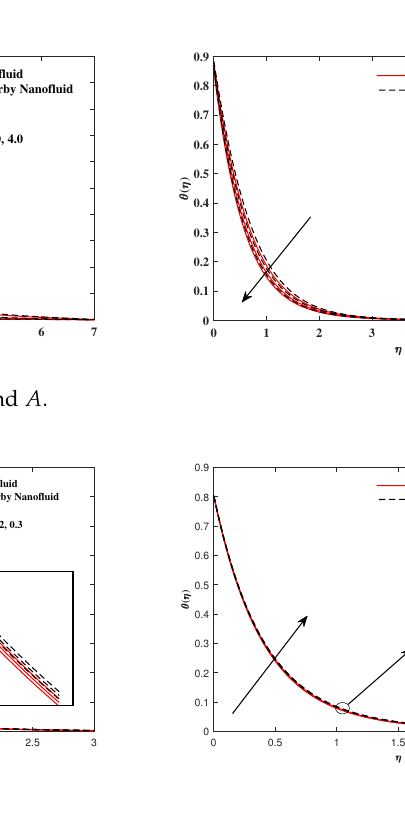
Figure 9. θ ( η ) with Nb and Nt